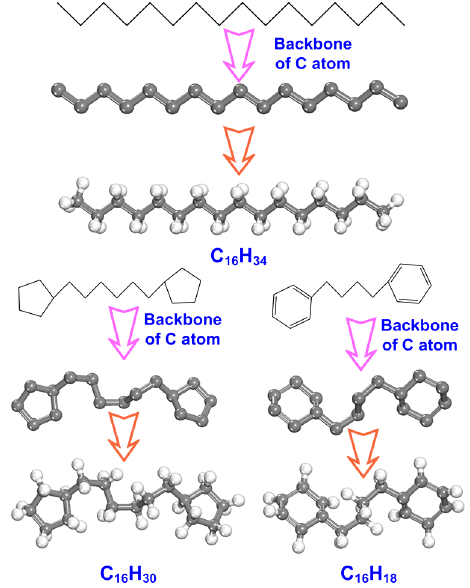
Figure 2. Main components of paraffin-based transformer oil.